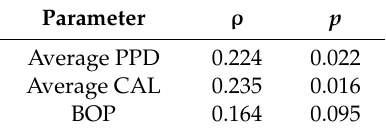
Table 3. Correlation between TLP-AA-Kit score and periodontal parameters. Parameter